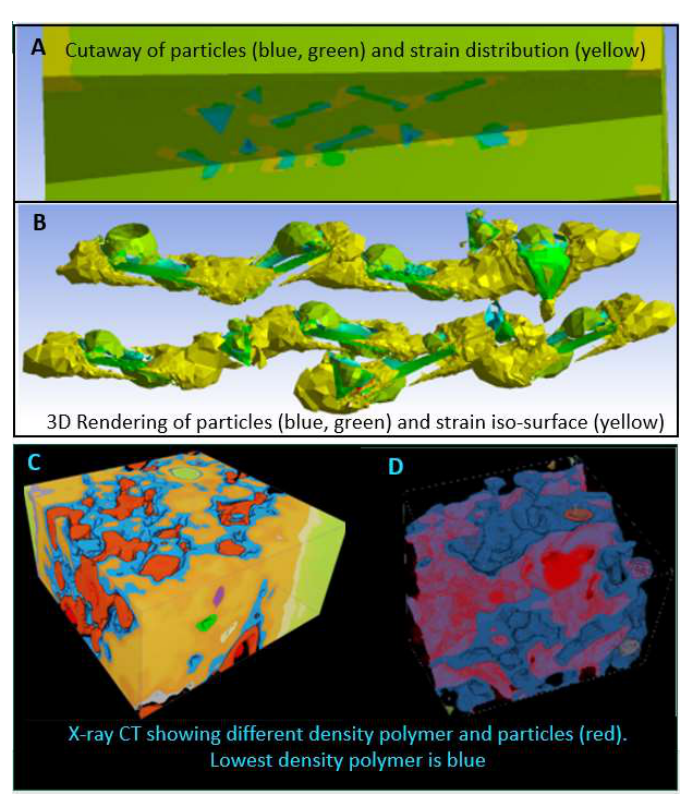
Figure 4. ( A ) Cutaway of an FEA of a particular arrangement of particles in a polymer matrix, ( B ) 3D rendering of a strain iso-surface (yellow) between particles (green and blue), ( C ) X-ray CT showing the density variation of polymer around particles (red), and ( D ) low-density polymer distribution around particles. Apated from Ranade et al. [58] and reproduced with permission.